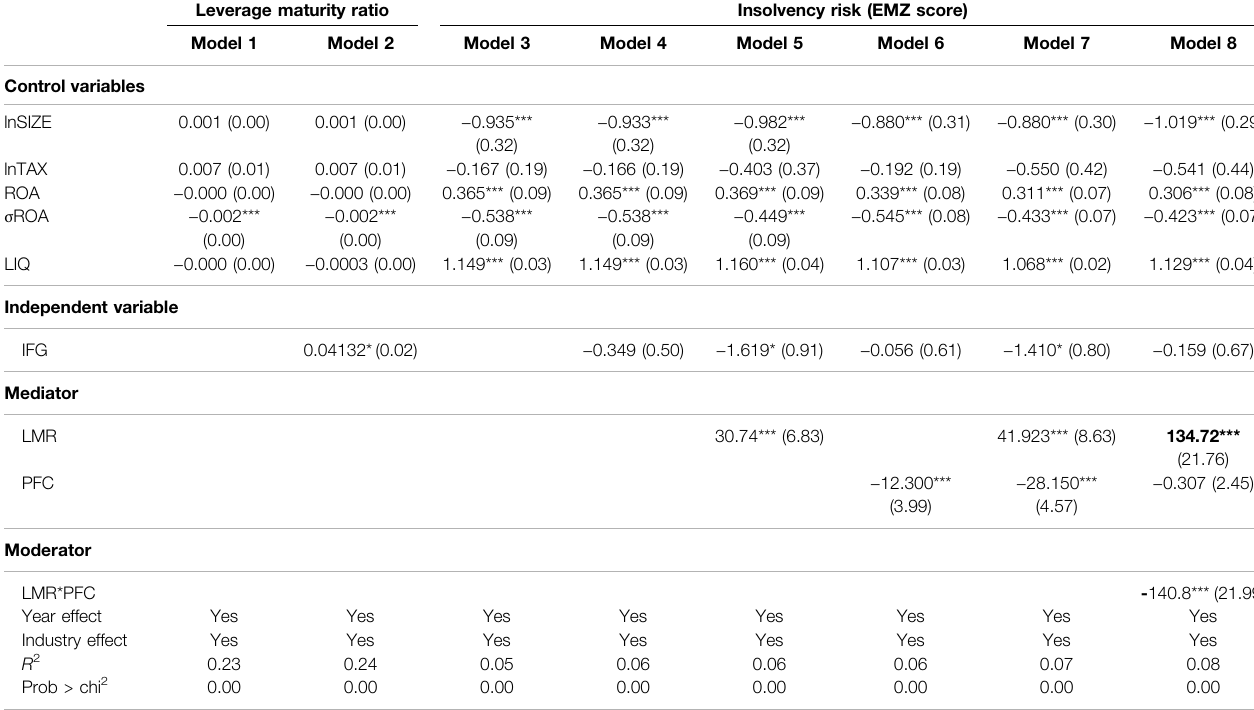
TABLE 6 | Hierarchical PCSE regression results with IFG as